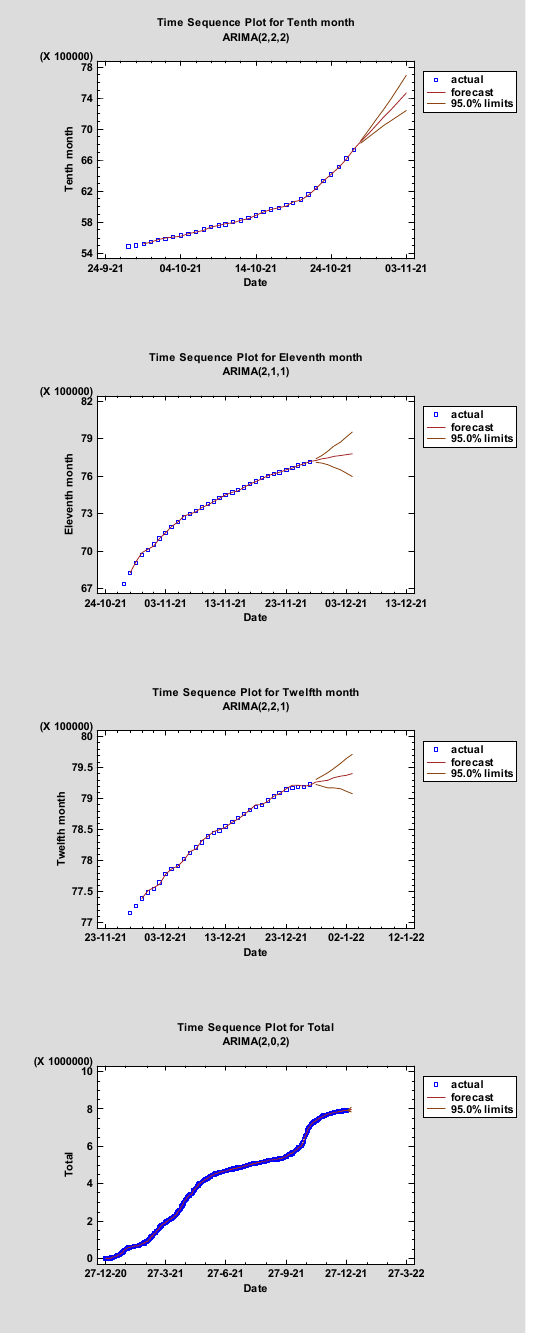
Figure 5. Forecast plots for ARIMA models in the next week per month and cumulative. In Figure 5 (left and right) are displayed the plots of the observed and forecasted maximized values for all twelve months and in total at 95.0% prediction limit for each forecast. Limits presented indicate the true value of each month and total at any point in future with likely to be with 95.0% confidence.